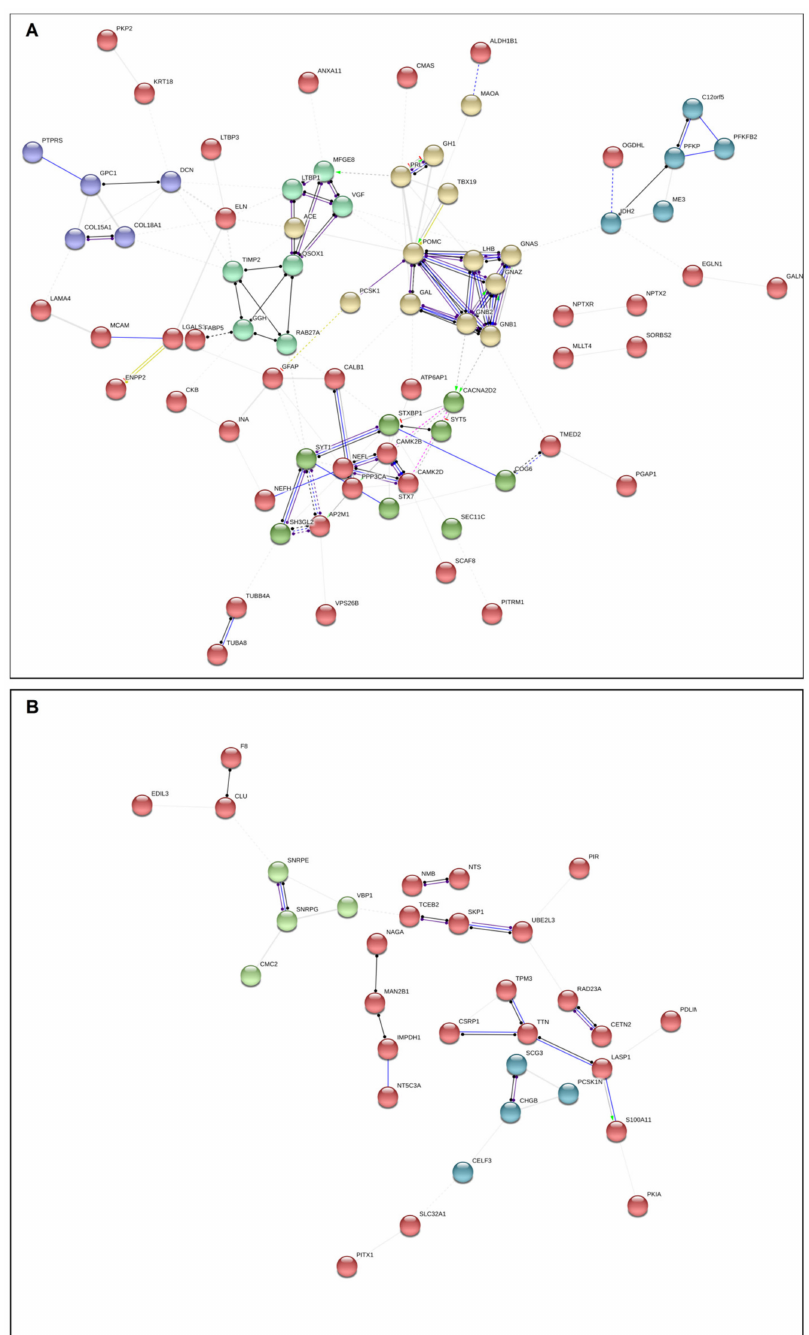
Figure 5. Network analysis presenting all DEP interactions in functioning (FCA) ( A ) and silent (SCA) ( B ) corticotroph adenomas. See Supplementary File S1 GO_matches_MS2 and online figures for FCA https: // version-11-0.string-db.org / cgi / network.pl?networkId = nBtGbCu86iDj and for SCA https: // version- 11-0.string-db.org / cgi / network.pl?networkId = eC3B7NayyvdC for more detailed information. The color of the circles indicates the result of a K-means algorithm for identifying clusters of genes according to their interaction